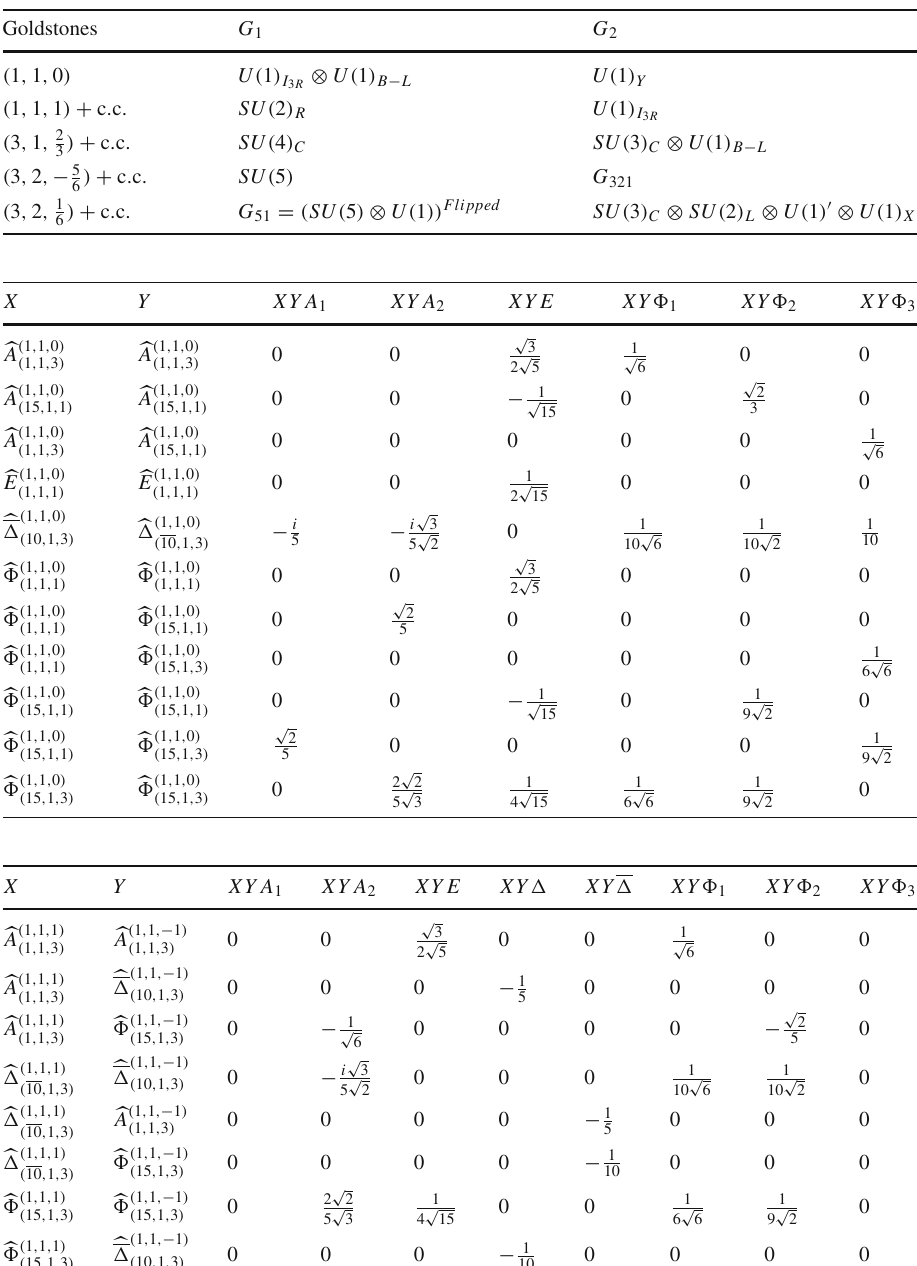
Table 1 The Goldstone modes and the corresponding SSB